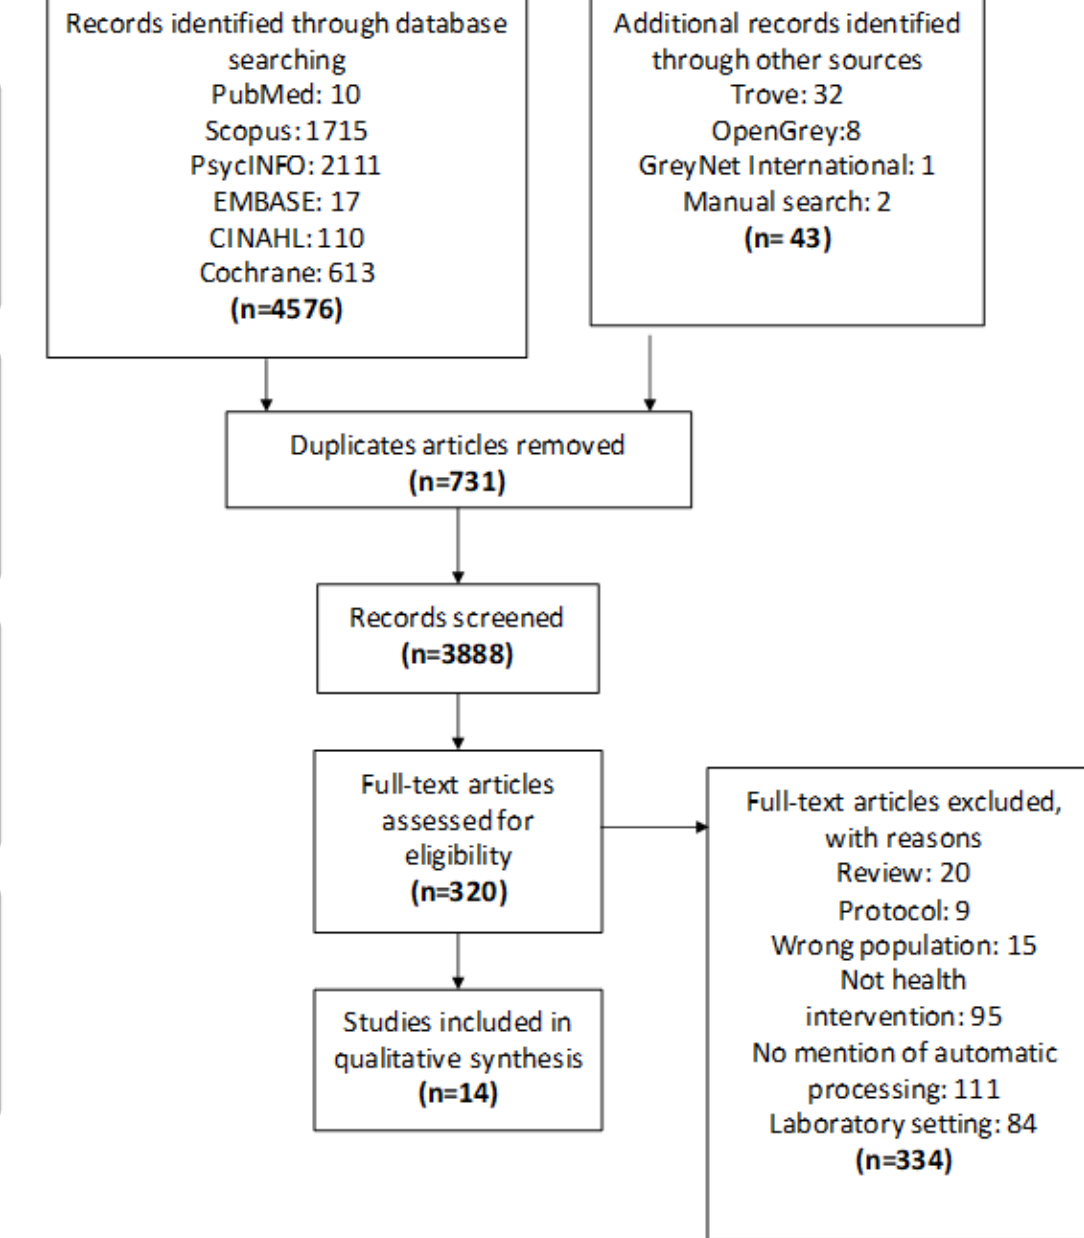
Figure 1. Preferred Reporting Items for Systematic Reviews and Meta-Analyses for the results of the search. CINAHL: Cumulative Index of Nursing and Allied Health Literature; EMBASE: Excerpta Medica Database; GreyNet: Grey Literature Network Service; PsycINFO: Psychological Information